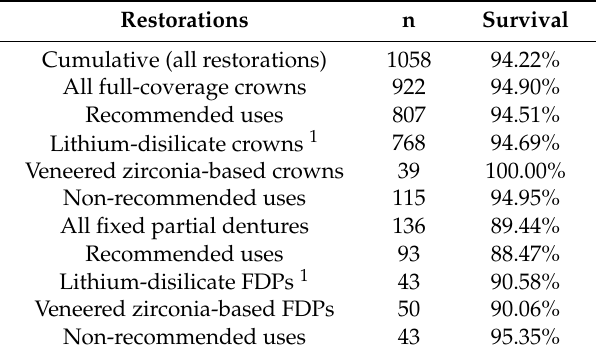
Table 4. Five-year Kaplan–Meier survival